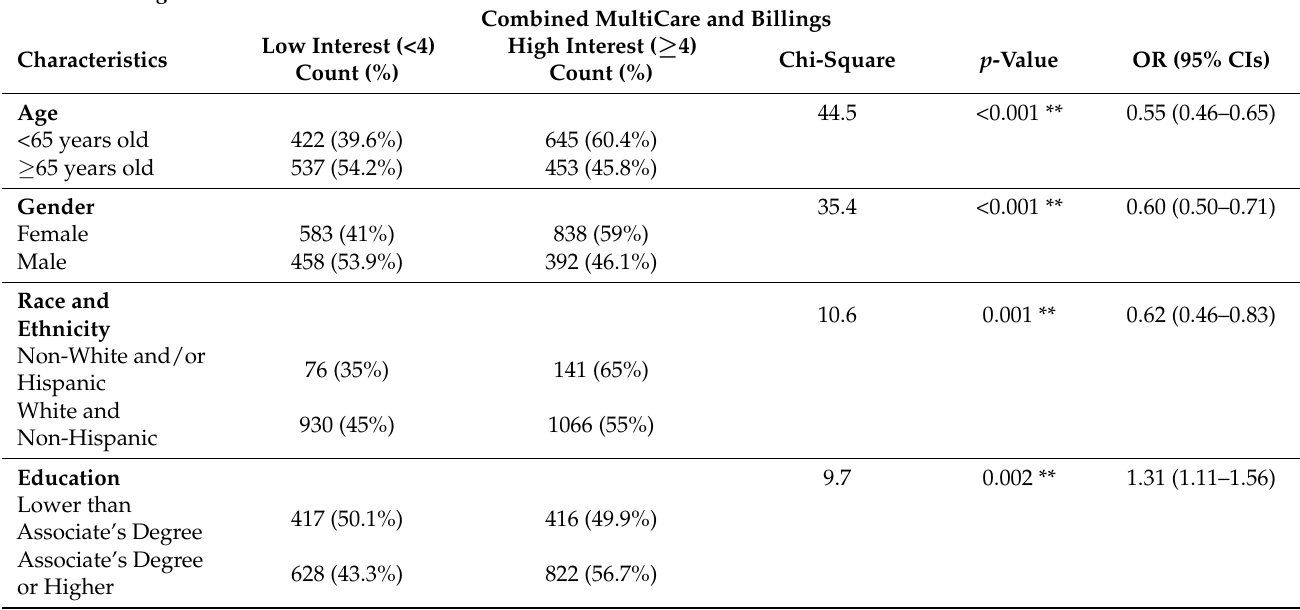
Table 2. Bivariate analysis for interest outcome